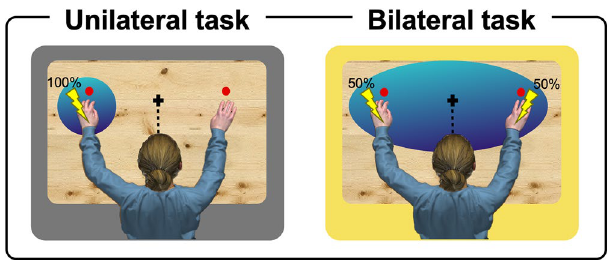
Figure 4. PPS plastic changes. The results suggest that the PPS boundaries are shaped according to the saliency afforded to each hand. When the probability of receiving a tactile stimulus is 100% on the left hand and 0% on the right hand, the PPS is limited to the space immediately surrounding the left hand. Conversely, when the probability of receiving a tactile stimulus is equally distributed between the two hands (50% on each hand), the PPS seems to enlarge as to include the space surrounding both